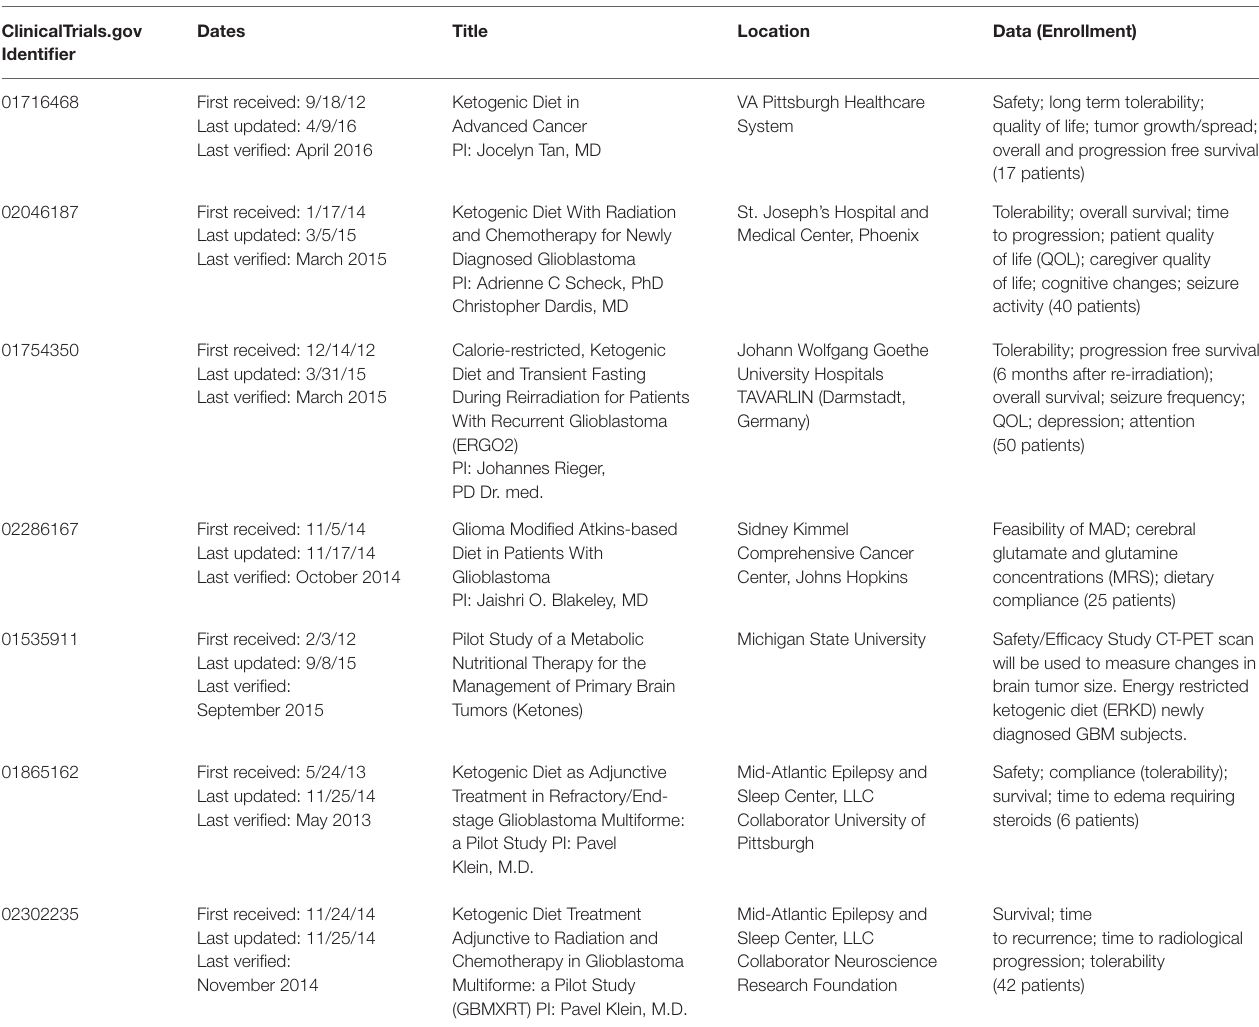
TABLE 1 | Active clinical trials: ketogenic diet and gliomas.